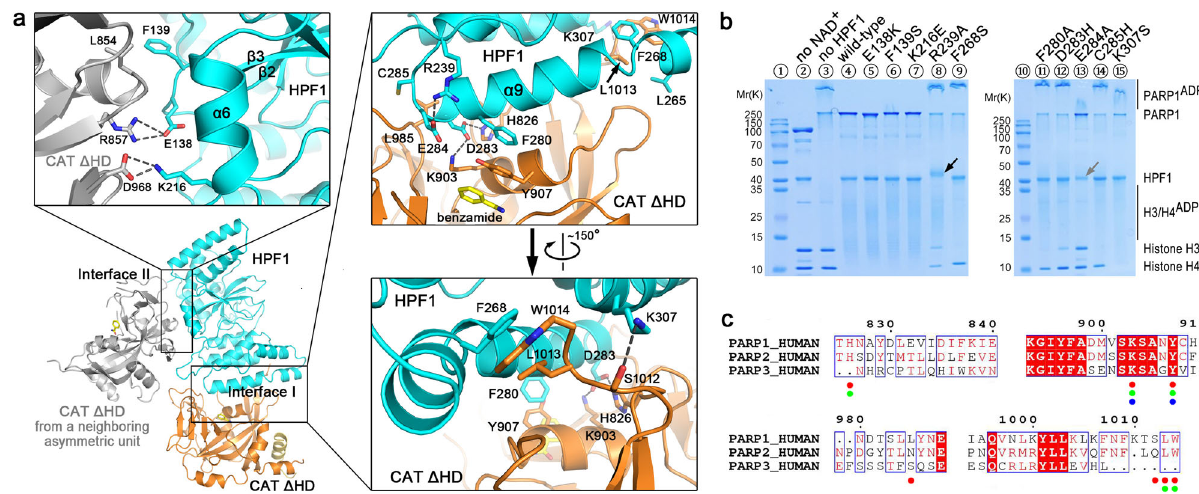
Fig. 2 Crystal structure of human HPF1/PARP1-CAT Δ HD and the binding mode between these two proteins. a Overall structure and the interaction details between human HPF1 and PARP1-CAT Δ HD. The overall structure of human HPF1/PARP1-CAT Δ HD is shown as cartoons. HPF1 and PARP1-CAT Δ HD are colored in cyan and orange, respectively. The gray-colored molecule on the left side indicates another PARP1-CAT Δ HD molecule from a neighboring crystallographic asymmetric unit that also contacts the HPF1 molecule, shown here due to close packing of molecules in the crystal. Therefore, the complex crystal structure indicated two possible interaction modes between HPF1 and PARP1-CAT Δ HD. The three insets show the key residues on the two interfaces that mediate the interactions between the HPF1 and PARP1 in the crystal. The dashed lines indicate polar interactions between the key residues. b Mutagenesis/ADP ribosylation studies to verify which key residues indicated in the crystal structure mediate HPF1 and PARP1 binding in solution. Hyper-automodi fi cation of PARP1 (shown by the smeared PARP1 ADPr bands on SDS-PAGE) was thought to indicate a loss of the interaction between HPF1 mutants and PARP1. Surprisingly, we noted that HPF1 R239A, but not any other HPF1 mutants, was robustly ADP-ribosylated in the assay (black arrow, also see Fig. 4c), while E284A seemed to be mildly ADP-ribosylated. The HPF1 E284A band became weaker, indicating a loss of unmodi fi ed protein in the assay (gray arrow). c Amino acid sequence alignment of human PARP1/2/3. The veri fi ed key residues that mediate HPF1 binding in PARP1 in solution are indicated by red dots. The corresponding residues in PARP2 and PARP3, if conserved in PARP1, are indicated by green and blue dots, respectively.